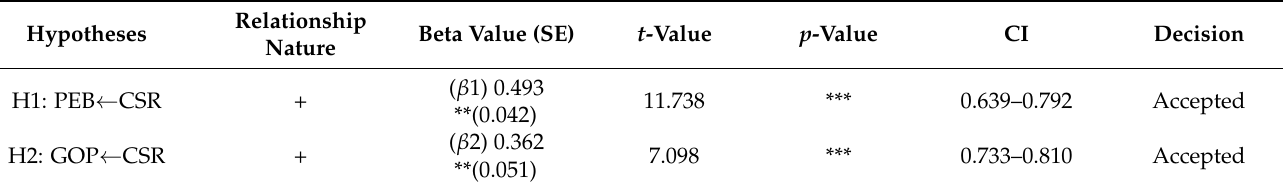
Table 5. Direct effect structural model results.